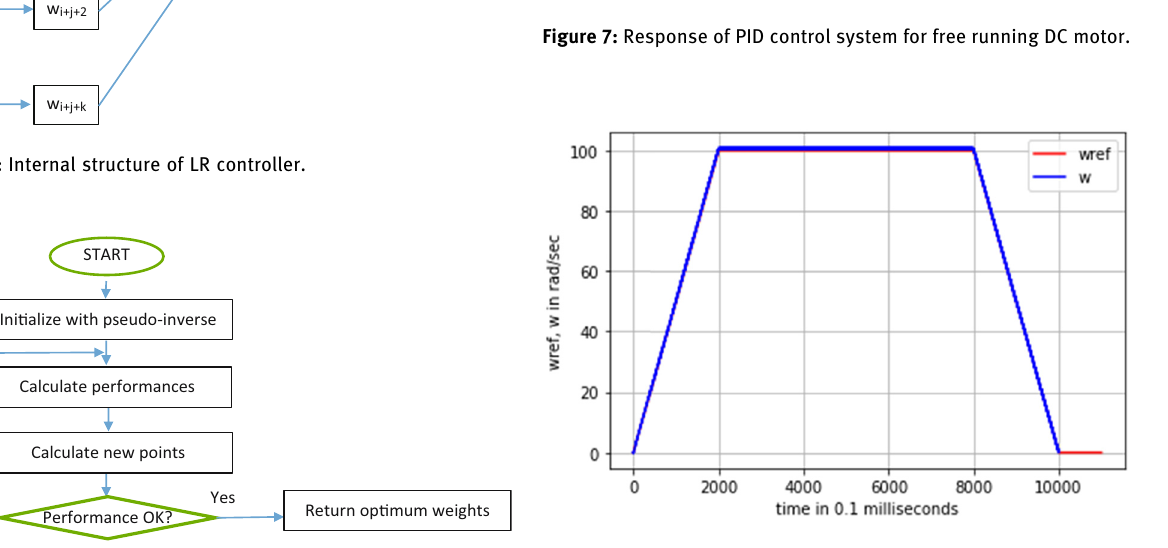
Figure 6: Optimizing LR controller.